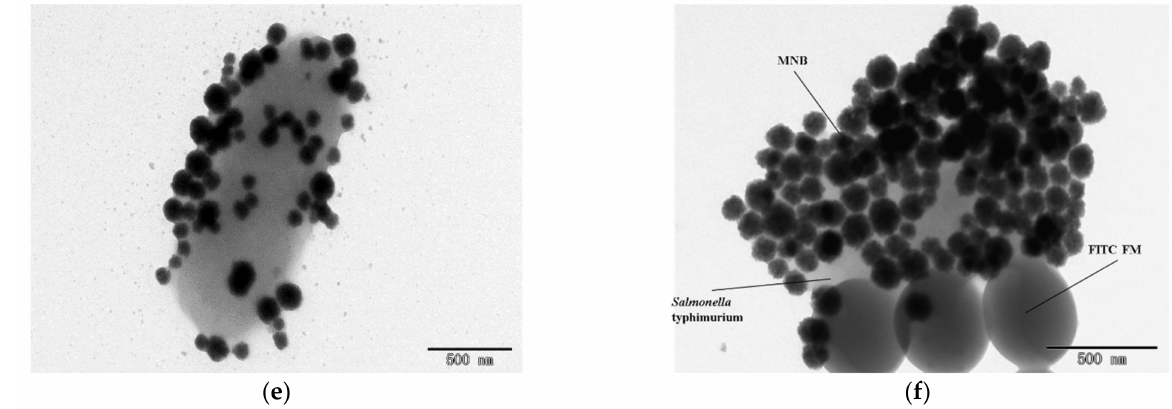
Figure 4. The performance characterization of this proposed fluorescent biosensor and the characterization of the materials used in this study. ( a ) The calibration curve of this fluorescent biosensor ( N = 3). ( b ) The specificity of this biosensor ( N = 3). ( c ) The TEM image of the MNBs. ( d ) The TEM image of the immune FITC FMs. ( e ) The TEM image of the magnetic bacteria. ( f ) The TEM image of the fluorescent bacteria.